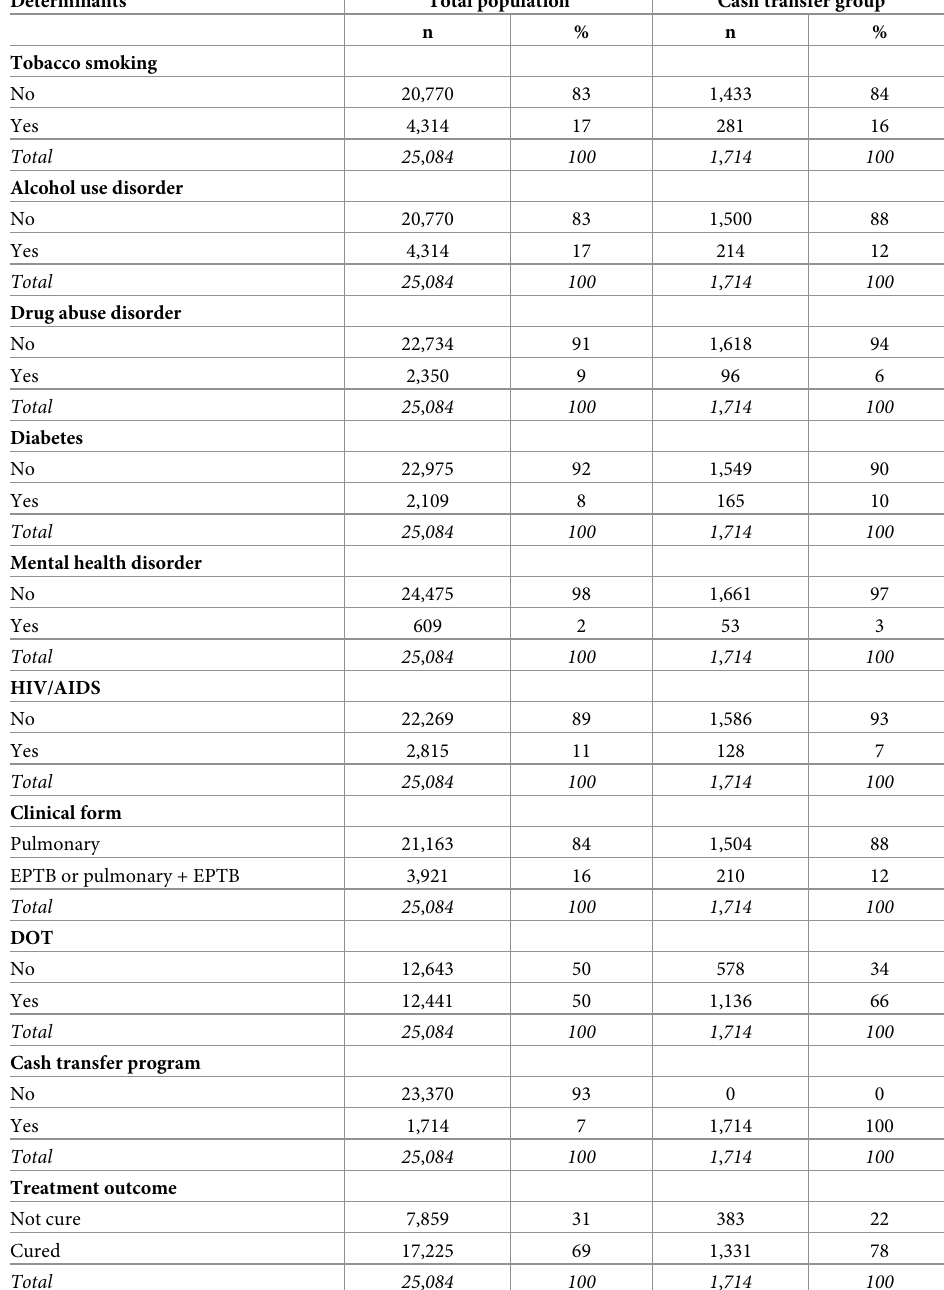
Table 2. Distribution of clinical determinants of tuberculosis among people from the Brazilian Notifiable Disease Information System database (SINAN), 2015.